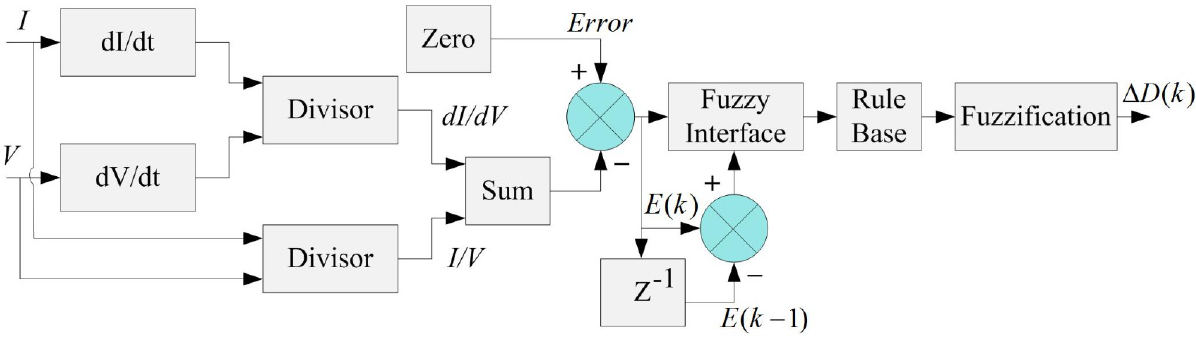
Figure 13. Block Diagram of F-LC